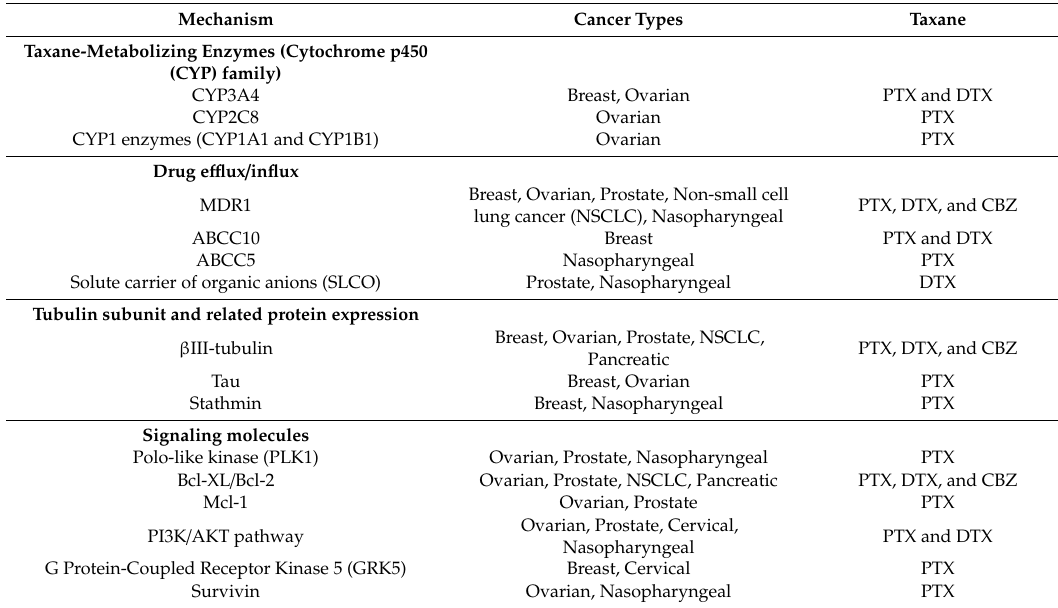
Table 1. Common resistance mechanisms. Mechanisms that are shared between more than 1 tumor type are grouped together here. See text for references.